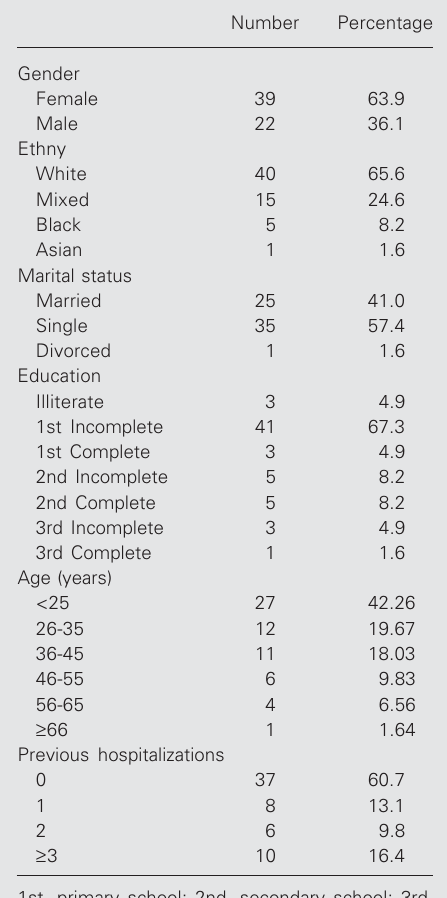
Table 1. Demographic characteristics of 61 pa- tients admitted to the Psychiatric Unit of the Ribeirão Preto General Hospital during the second semester of 1994.